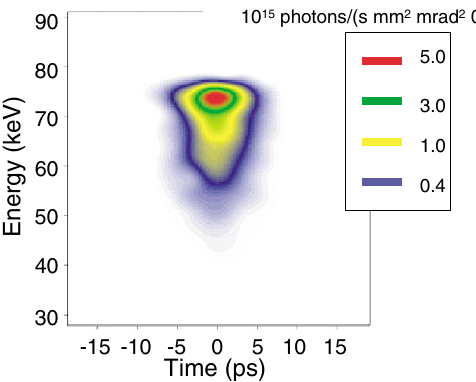
FIG. 11. (Color) On axis time-dependent x-ray spectrum of the experimentally produced x-ray beam as determined by the 3D time and frequency-domain